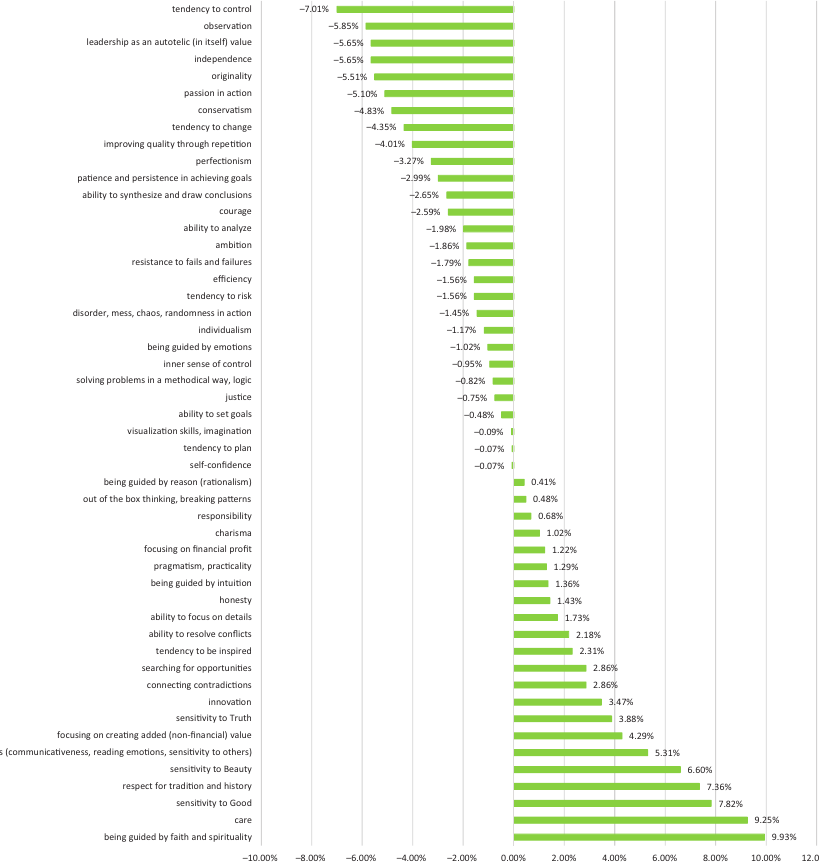
Figure 10. Perception of the most differently assessed features of a manager’s identity by artistic ver- sus non-artistic individuals (source: created by author)